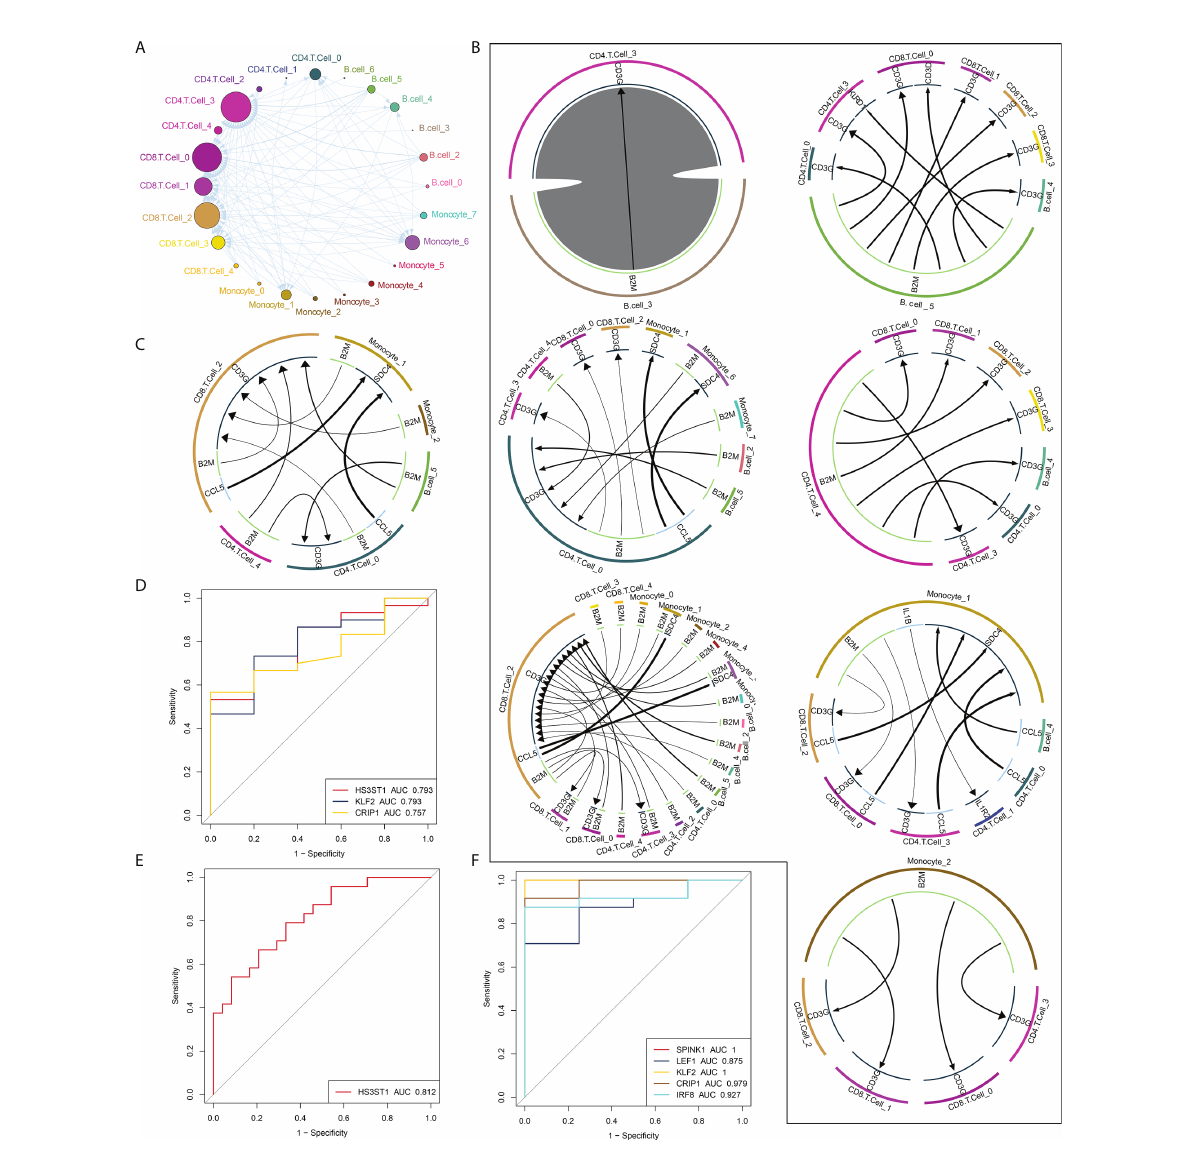
FIGURE 4 Global regulatory network of microenvironmental immune cells in RT-induced intestinal tissues. (A) Radiation reprogramming of the immune cell communication network. Different colors represent different cell types. (B) The communication network between immune cells and other cells. The outer circle of the Circos diagram shows the cell type, and the inner circle shows the details of each interacting ligand-receptor pair. The lines and arrows in the Circos diagram are scaled to indicate the relative signal intensity of the ligand and receptor, respectively. (C) Radiation-speci fi c immune cell communication network. (D – F) . Composite ROC curves showing the diagnostic ef fi ciency of core cell marker genes. Different curves represent different genes, and the closer the AUC value is to 1, the stronger the diagnostic ability of the gene. ROC, receiver operating characteristic; AUC, area under the ROC